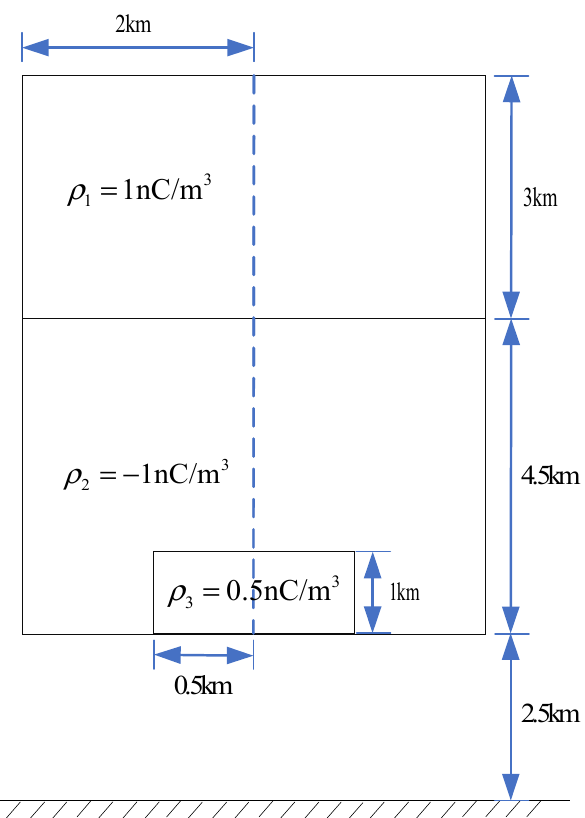
Figure 6. Typical tertiary charge structure of a thunderstorm cloud.